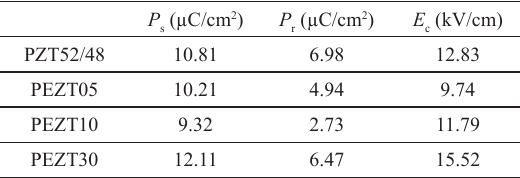
) and remnant polarization ( P Table 3. Saturation ( P s field ( E ) determined from the measured hysteresis loop for every c studied sample.